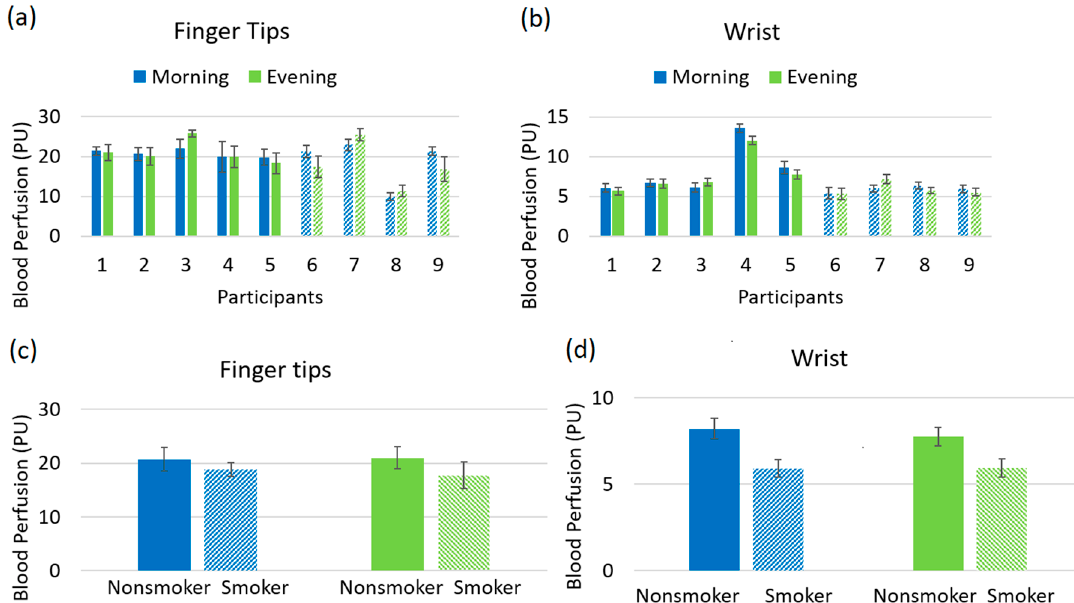
Figure 3. ( a ) Blood perfusion with standard deviation of left fingertip for every participant; ( b ) blood perfusion with standard deviation of left wrist for every participant; ( c ) averaged blood perfusion with standard deviation of fingertip for non-smoker and smoker, ( d ) averaged blood perfusion with standard deviation of wrist for non-smoker and smoker (solid bar denotes non-smoker and patterned bar denotes smoker).